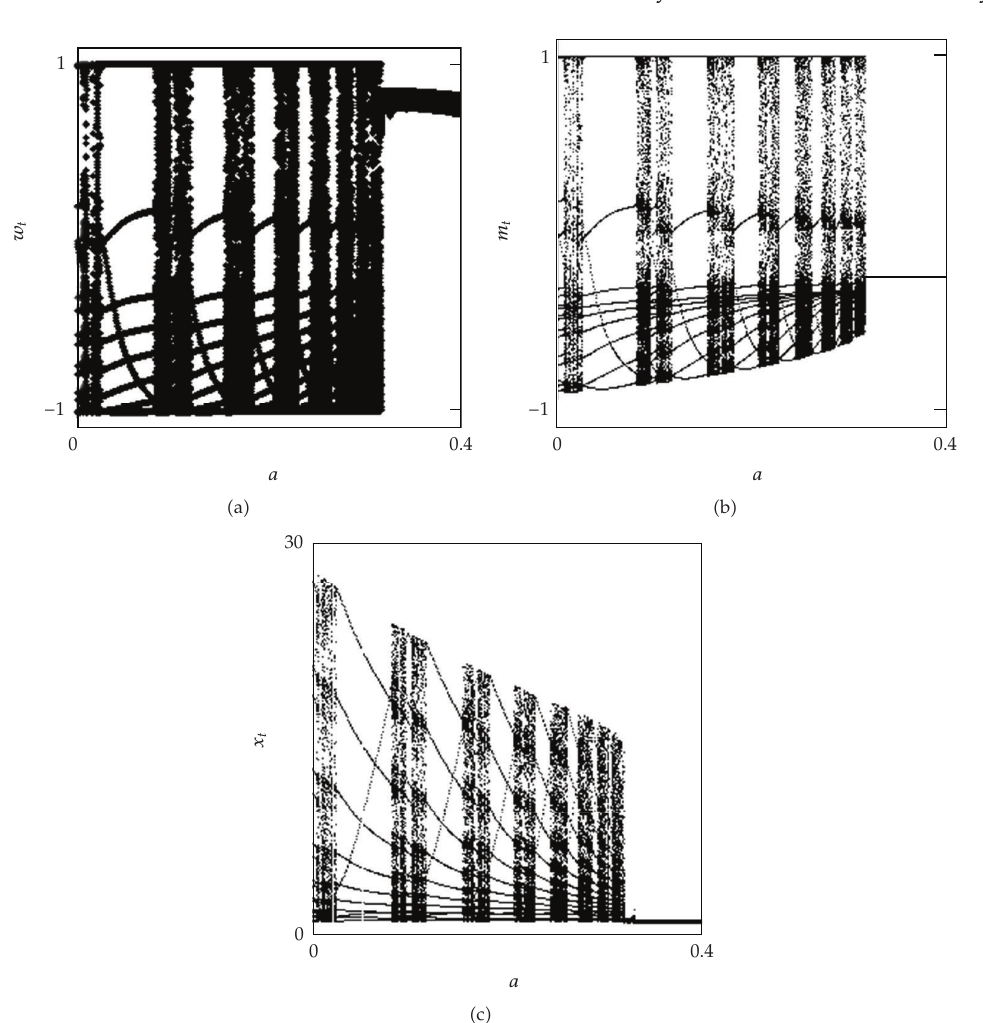
Figure 6: Bifurcation diagrams of the state variables w.r.t. a . Initial condition and parameter values as in Figure